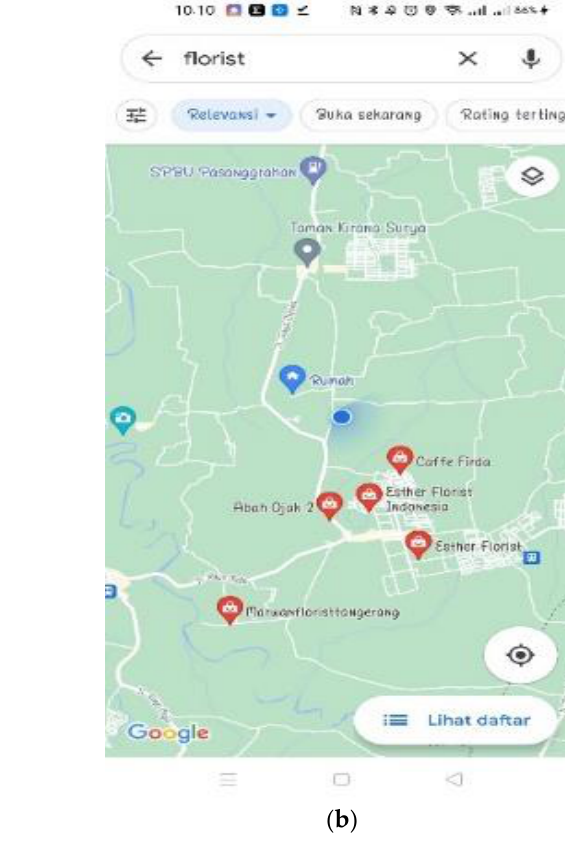
Figure 6. Mobile apps user interface. ( a ) Disease detection page; ( b ) shop search page.